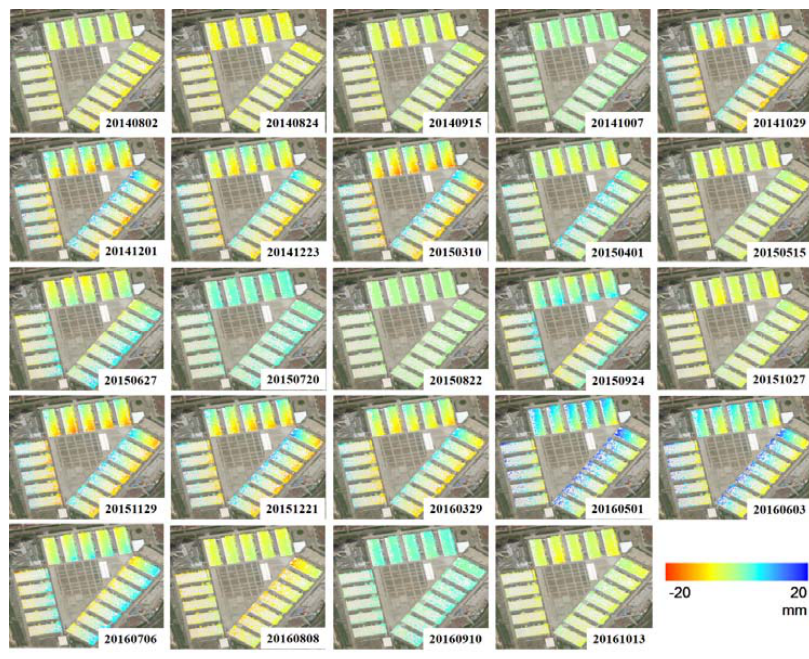
Figure 10. The time series horizontal displacements of the SNIEC.